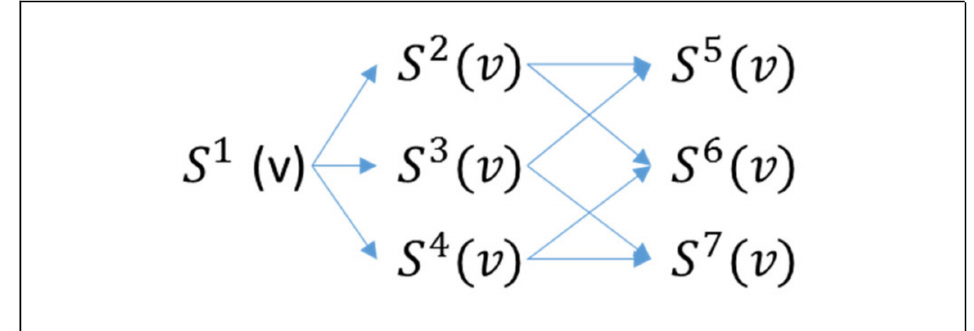
Figure 10. Model